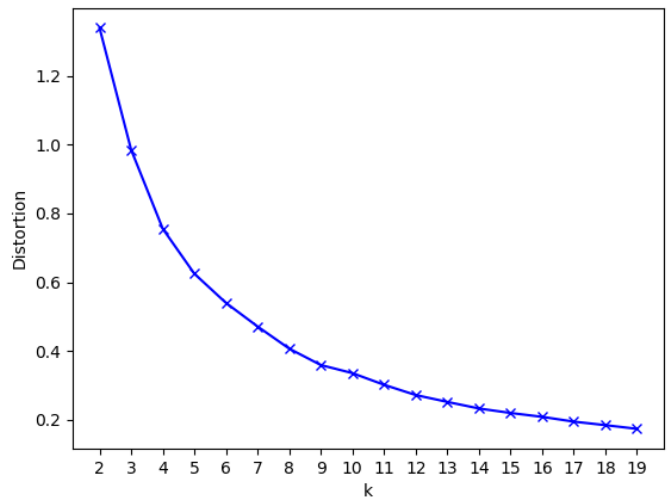
Figure 7. Elbow chart, giving a hint for defining the optimal number of driving style categories. Table 5. Centroids of the Clusters for K = 5 and K = 9.